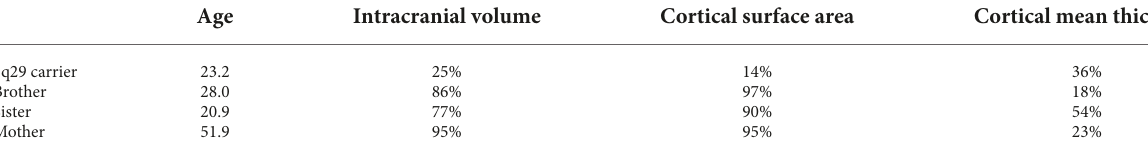
TABLE 1 Percentiles in a magnetic resonance imaging dataset of n = 270 healthy controls. Age Intracranial volume Cortical surface area